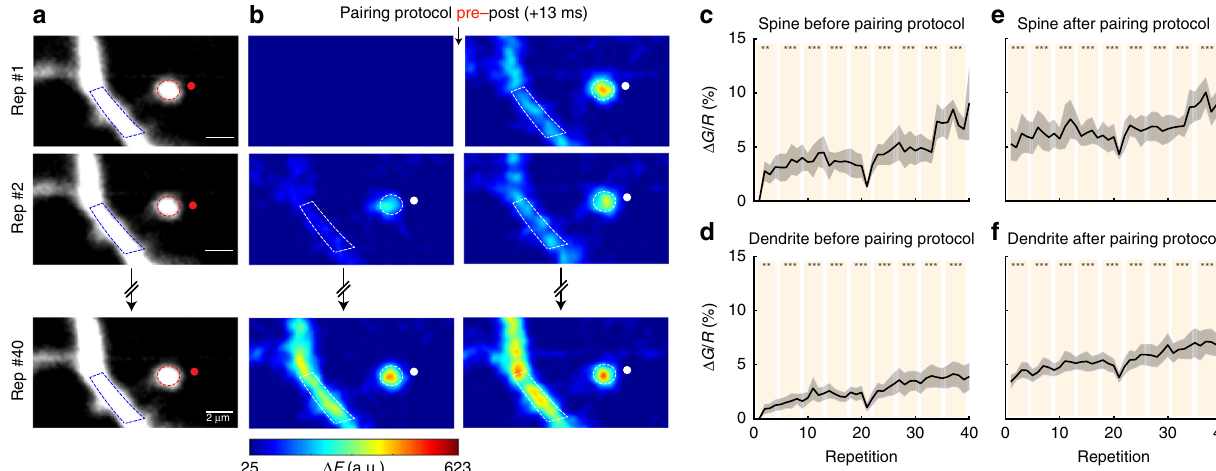
Fig. 7 Calcium dynamics in single spines during a pre – post pairing protocol of + 13 ms. a Single 2P images of a spine and dendrite from an L5 pyramidal neuron loaded with Alexa Fluor 594 (shown in a ) and Fluo-4 (shown in b). Red ellipses and blue polygons indicate the ROIs selected for analysis. b Two- photon calcium signal images before (left panels) and after (right panels) a pre – post pairing of + 13 ms. The 1st, 2nd, and 40th repetitions of the pairing protocol are shown. The change in calcium fl uorescence from baseline ( Δ F ) is color coded. Only positive changes in fl uorescence are shown. White ellipses and polygons indicate the ROIs selected for analysis. c – f Population averages of the calcium signals ( Δ G R ) measured in c , e spines and d , f dendrites before ( c , d , P < 0.001 and 0.001, n = 12 spines and dendrites, one-way repeated-measures ANOVA) and after ( e , f , P < 0.001 and 0.001, n = 12 spines and dendrites, one-way repeated-measures ANOVA) the pairing protocol. Shaded area represents SEM. ** P < 0.01; *** P < 0.001, post hoc Dunnet ’ s test. a.u. arbitrary unit, rep